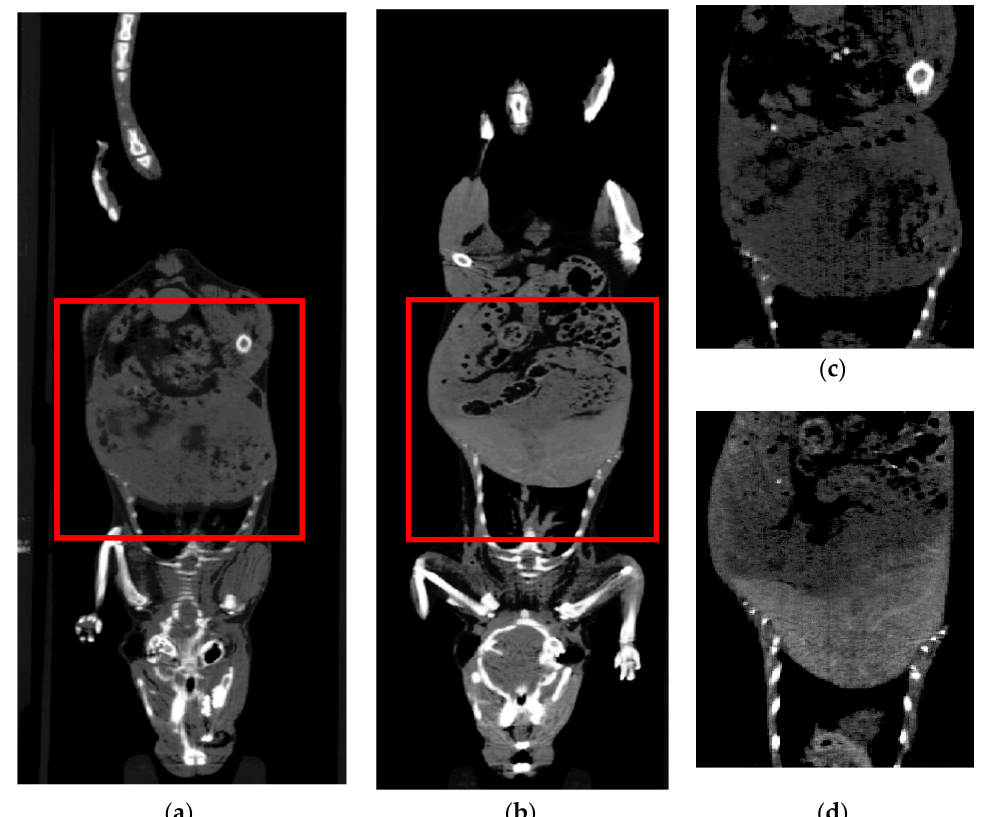
Figure 10. Coronal CT images of the mouse ( a , c ) before and ( b , d ) after administration of GdF 3 :Tb 3+ ,Yb 3+ ,Nd 3+ @P(DMA-AGME)-Ale nanoparticles; ( c , d ) enlarged CT view of the abdomen. 3.8. In Vivo Optical Imaging of GdF 3 :Tb 3+ ,Yb 3+ ,Nd 3+ @P(DMA-AGME)-Ale-Cy7